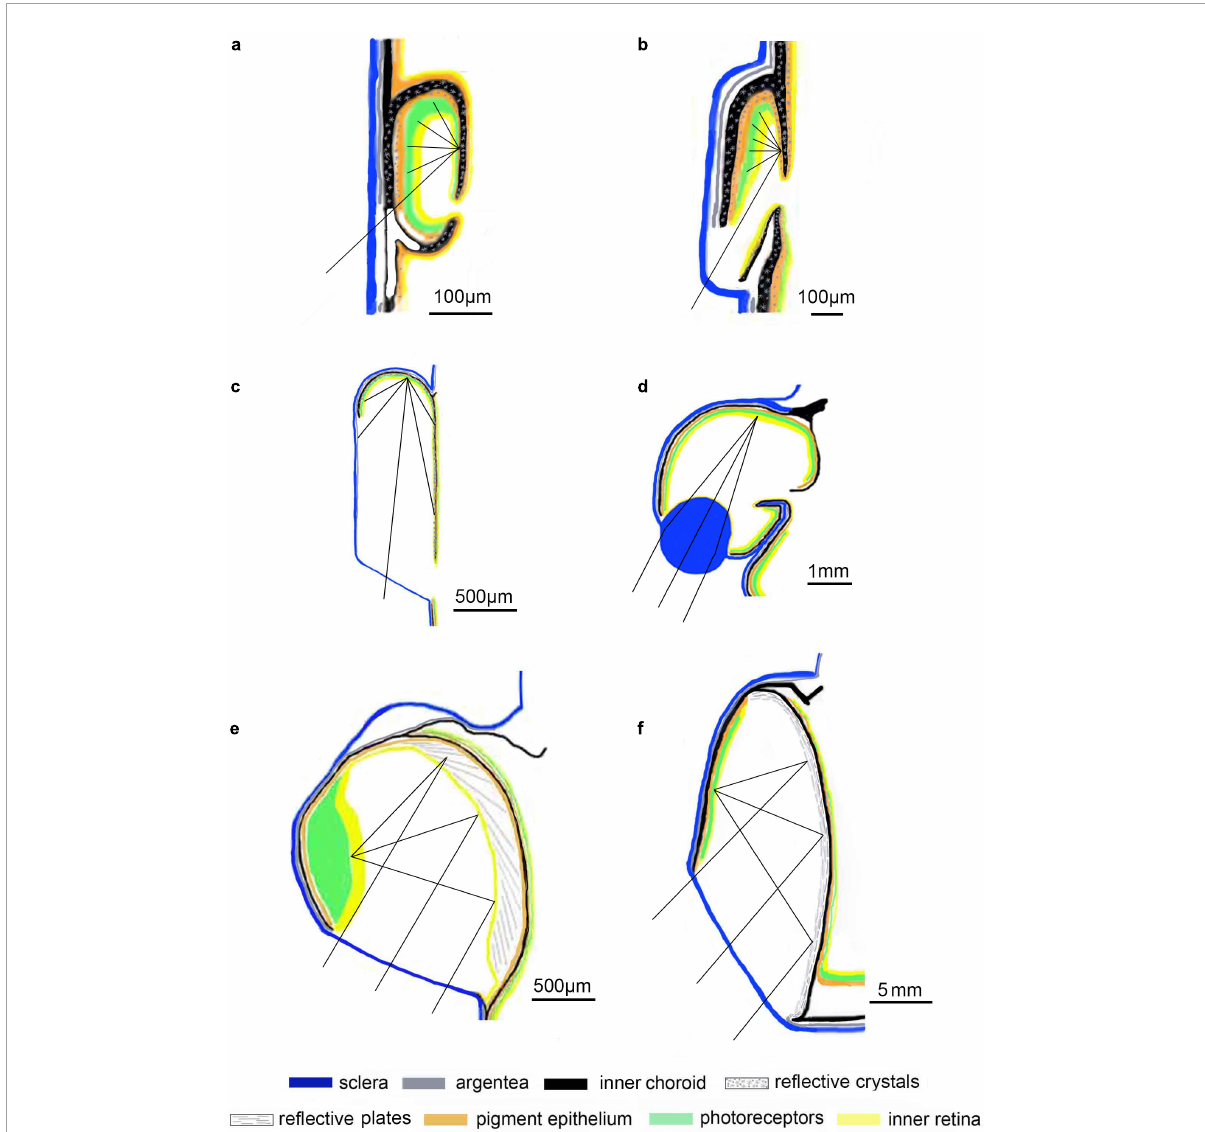
FIGURE10 Schematic representation of Opisthoproctid diverticula: In all diagrams the main, usually tubular, portion of the eye would be to the right of the diverticulum. The possible path of light rays entering the diverticula are shown; (a) Opisthoproctus soleatus . The small diverticulum is positioned rostrolaterally just ventral to the corneoscleral junction. Light enters the diverticulum through an unpigmented ventrolaterally facing ‘window’ and, due to the disorganised orientation of the reflective crystals in the choroid and retinal tapetum medially, produces an unfocused image on the lateral diverticular retina; (b) Winteria telescopa . Due to the normally rostral orientation of the eye (not indicated here), the small diverticulum is located ventrolaterally and samples the caudolateral visual field. As in O. soleatus , illumination enters the diverticulum through an unpigmented area, allowing only unfocussed light perception; (c) Macropinna microstoma . The largest specimen sampled had a rostrolateral diverticulum covering around half of the lateral wall of the tube eye with a dorsal retina and a ventral cornea. Although our understanding of this diverticulum is incomplete, it seems unlikely that light entering the diverticulum produces a focussed image; (d) Bathylychnops exilis . The large rostrolateral diverticulum is characterised by a prominent, sclerally derived, lens. The light rays entering the diverticulum ventrolaterally are shown as focussed on the diverticula retina on the unproven assumption that the scleral lens is sufficiently refractive; (e) Dolichopteryx longipes . Ventrolateral illumination enters a large, laterally protruding, dorsal diverticulum through a cornea and impinges on the medial wall of the diverticulum, whose retinal-derived reflective plates change orientation throughout the diverticulum and produce a focussed image on a lateral retina (Wagner et al., 2009); (f) Rhynchohyalus natalensis . A large diverticulum covers the entire lateral wall of the tubular portion of the eye. Light entering the ventrolaterally directed diverticular cornea hits the medial wall whose choroidally derived reflective plates are all orientated approximately parallel to the surface and form an image on the lateral retina (Partridge et al., 2014). For those eyes in which a focussed image may be formed (d–f) , three entrant rays are shown converging to one point on the retina. For eyes in which the crystals in the RPE/choroid are disorganised, suggesting a more diffuse reflective surface (a,b) , only one entrant ray is shown with representative rays shown reflected at different